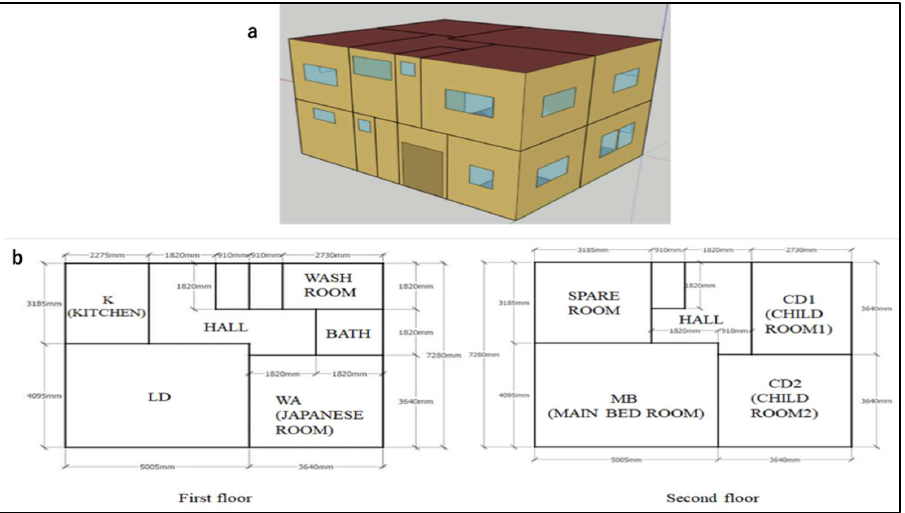
Figure 3. Layouts of the selected building: ( a ) 3D layout; ( b ) 2D Layout. Figure 3. layouts of the selected building: ( a ) 3D layout; (b) 2D Layout Figure 3. layouts of the selected building: ( a ) 3D layout; (b) 2D Layout